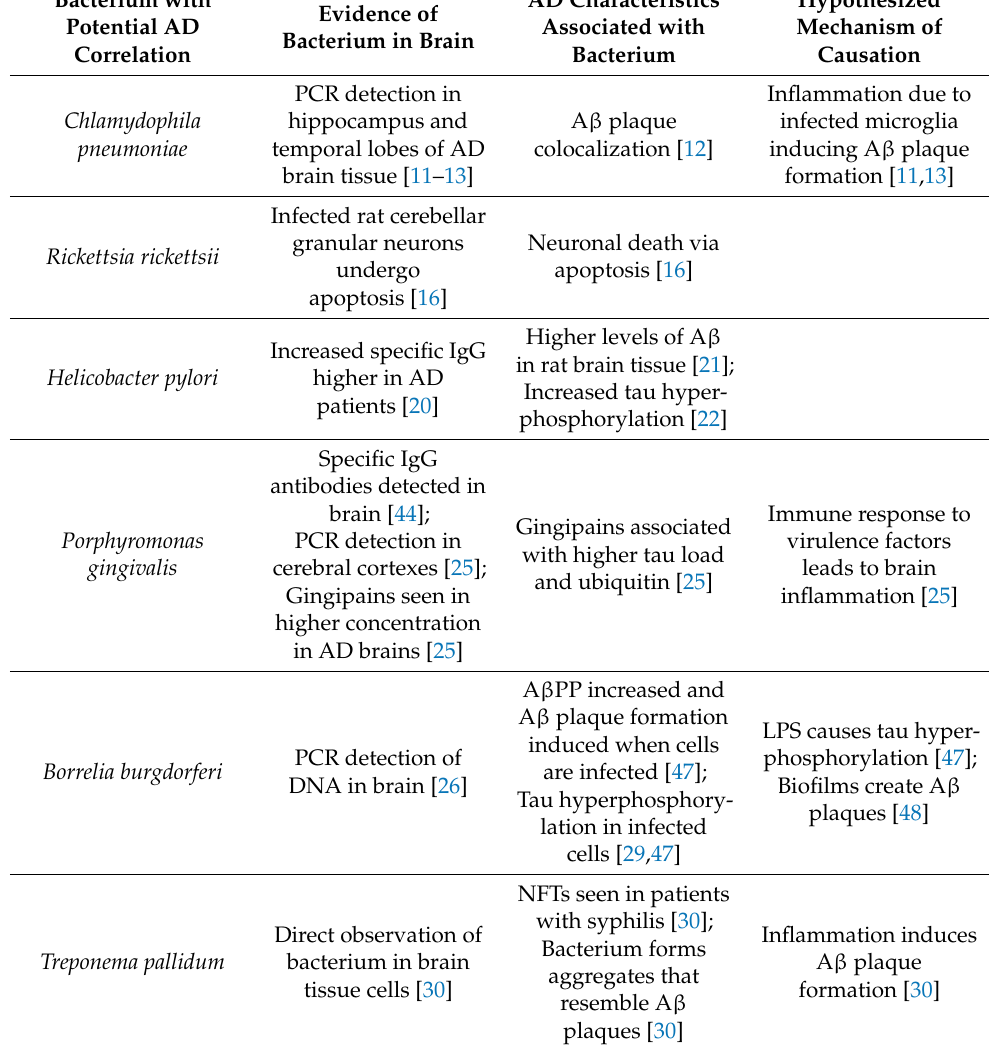
Table 2. A summary of bacteria that have been studied in association with AD, the characteristics of AD that are concurrent with the bacterium, and the hypothesized mechanism of